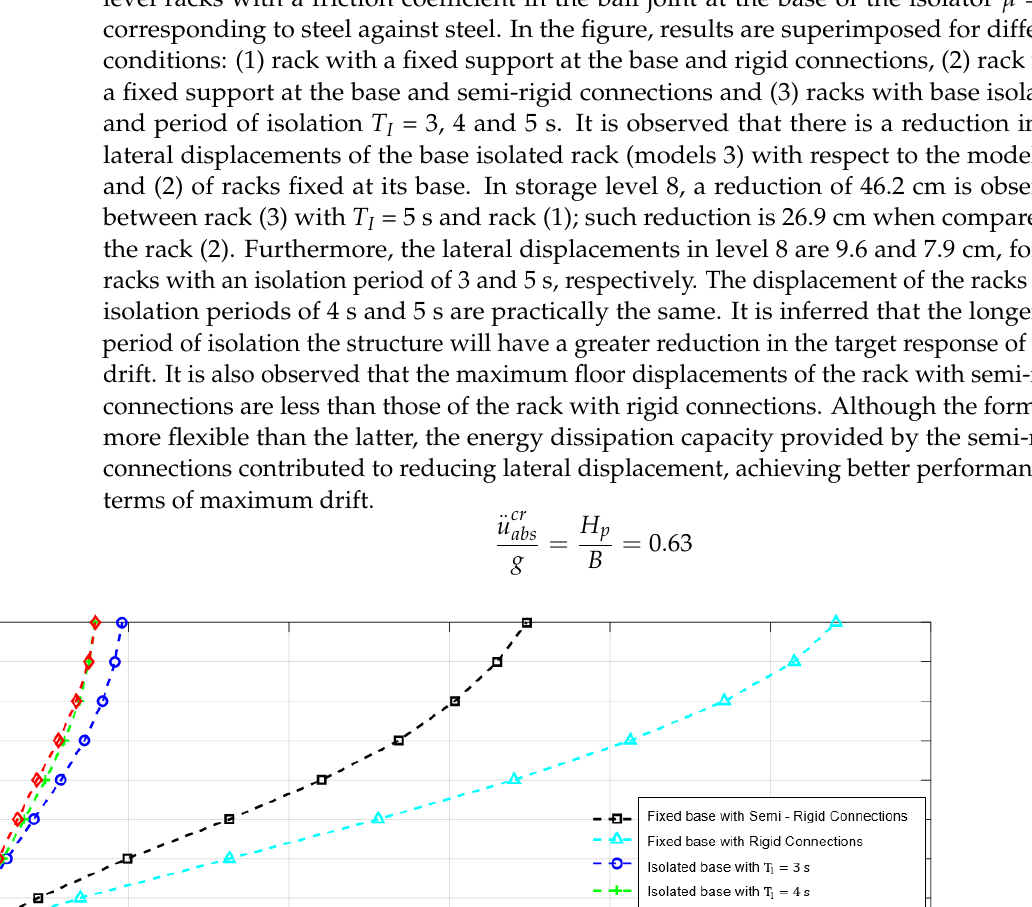
Figure 12. Lateral displacement of the load levels of 8-level racks with fixed support at the base and with base isolation.